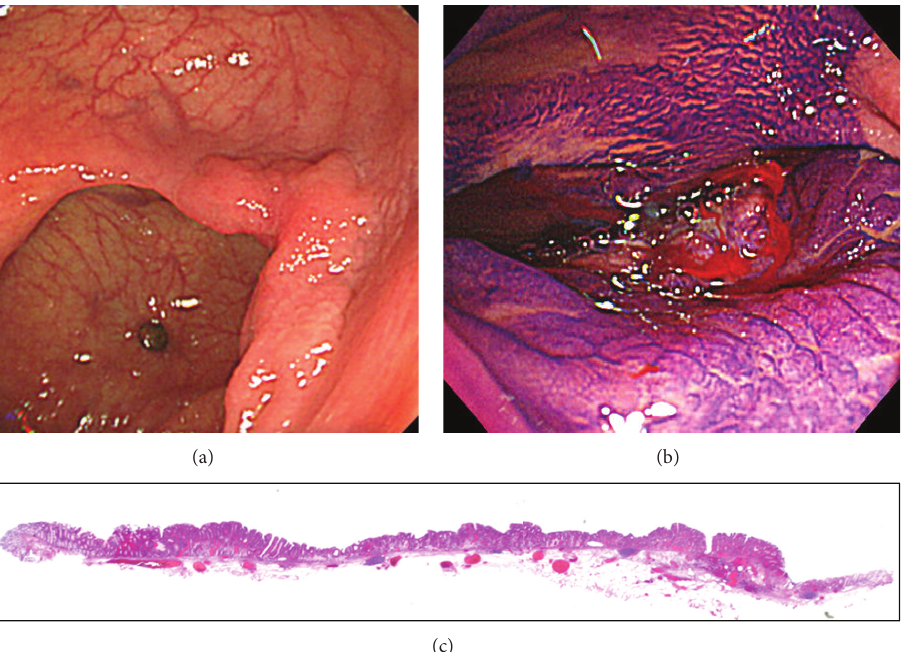
Figure 1: (a) A typical case of a laterally spreading tumor of the nongranular type (LST-NG) located in the cecum. (b) Despite any previous manipulation, the lesion showed a nonlifting sign. (c) The lesion removed en bloc by endoscopic submucosal dissection was found to be an intramucosal